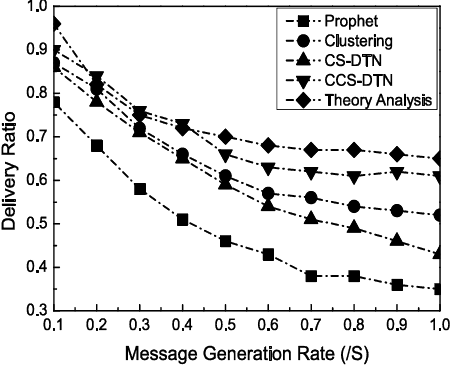
Figure 7. Impact of Message Generation Rate (/s).